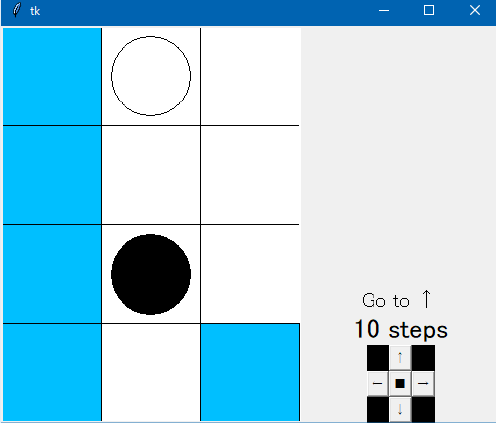
Figure 4. Application interface with which subjects controlled an